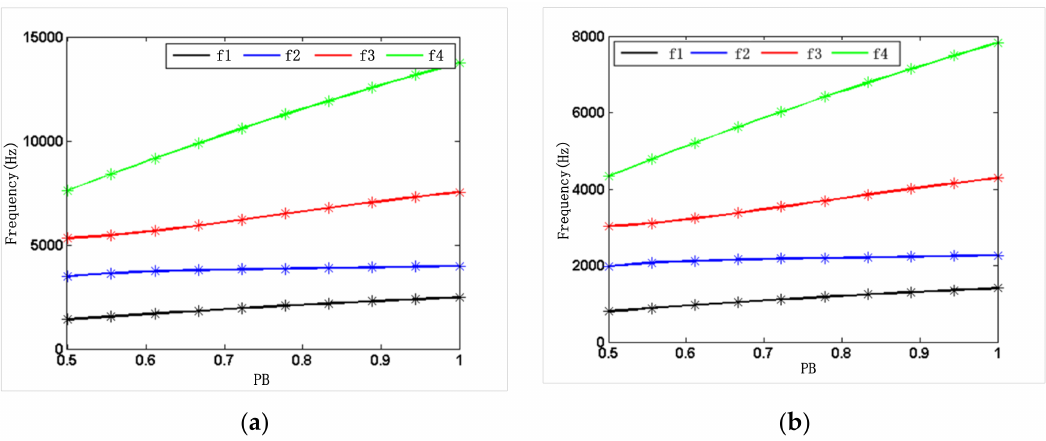
Figure 6. Theoretical and numerical frequencies of the resonator at a fixed-length ratio: ( a ) silicon; ( b )